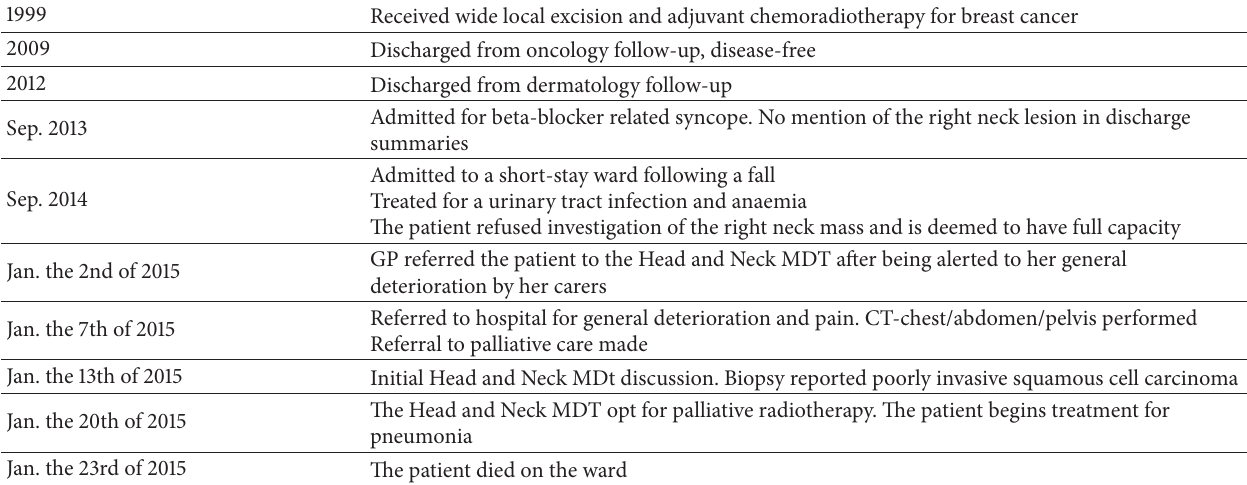
Table 1: A timeline of events.